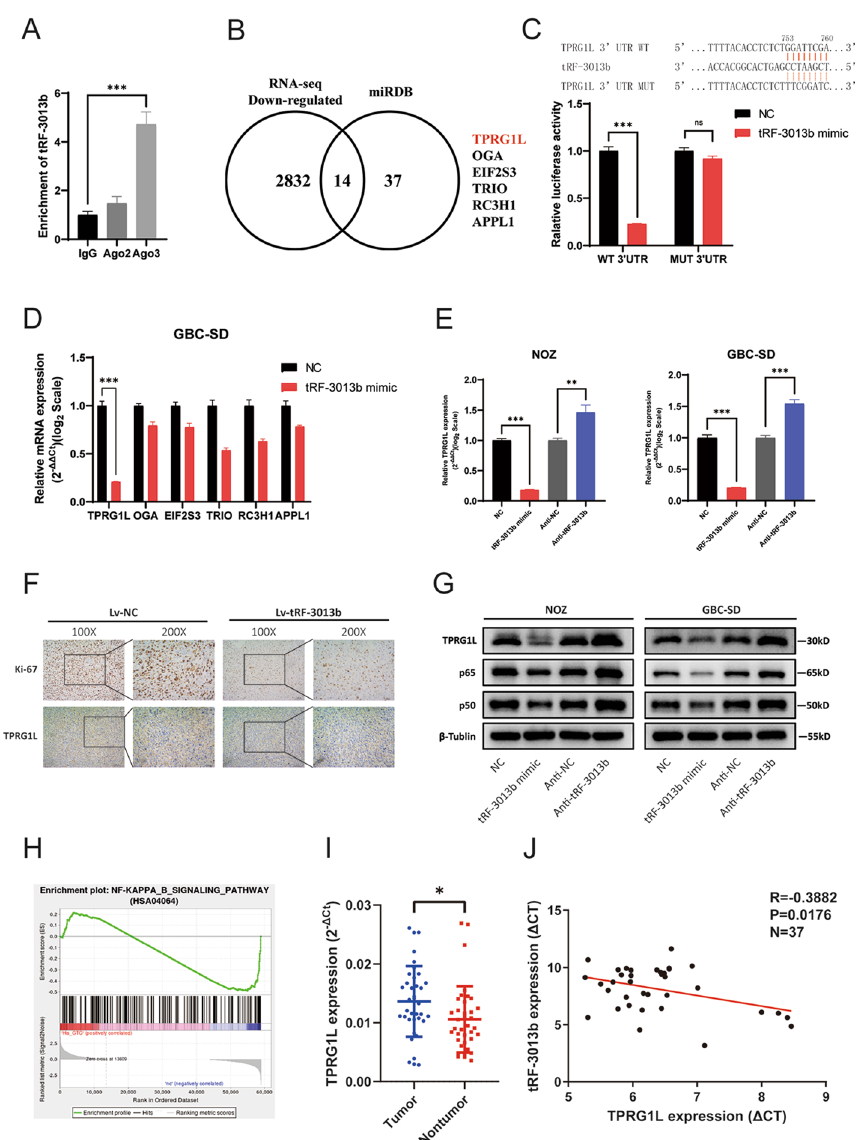
Fig. 5 TPRG1L was a direct target of tRF-3013b. A The enrichment between AGO2, AGO3, and tRF-3013b was detected by RIP-qPCR. B Potential tRF-3013b targets intersected by RNA-seq and miRDB. C Sequence of the predicted tRF-3013b binding site within the 3 ′ -UTR of TPRG1L. Relative luciferase activity was detected after cotransfection of NC or tRF-3013b mimic and reporter plasmids into 293T cells. D Relative mRNA expression of potential target genes after transfection with NC or tRF-3013b mimic in GBC cells. E Relative mRNA expression of TPRG1L after overexpression and inhibition of tRF-3013b NOZ and GBC-SD cells. F IHC showing Ki-67 and TPRG1L protein expression in xenograft transfected Lv-NC or LV-tRF-3013b. G Relative protein expression of TPRG1L, p65, and p50 after overexpression and inhibition of tRF-3013b in NOZ and GBC-SD cells. H Enrichment plot of NF-κB signaling pathway analyzed with GSEA after transfection with NC or tRF-3013b mimic in NOZ cells. I TPRG1L expression level in 37 pairs of GBC and para-cancer tissues. J Linear regression analysis and paired t -test for determining the correlation between the expression levels of tRF-3013b and TPRG1L. ns P > 0.05, * P < 0.05, ** P < 0.01, *** P <